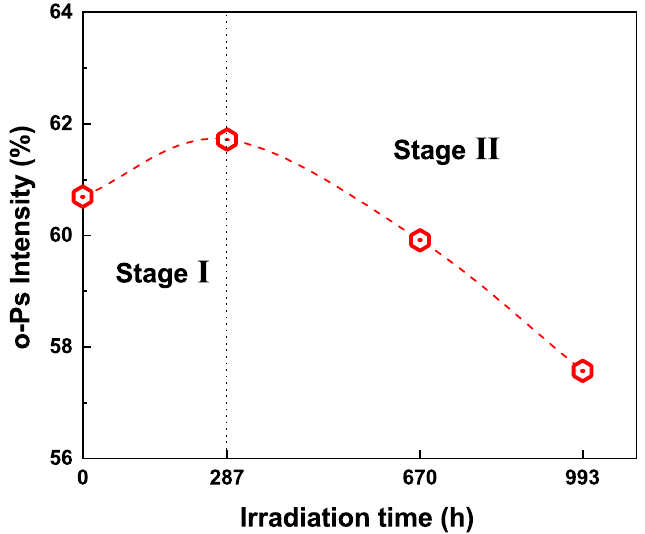
Figure 8. The o-Ps intensity of silicone rubber after different durations of UVB